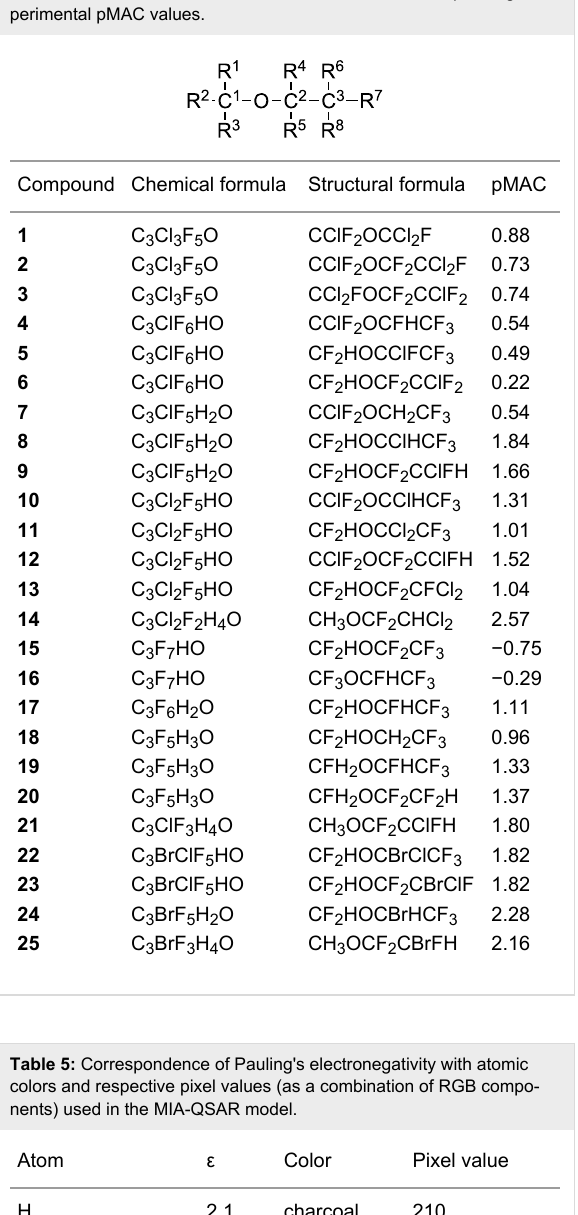
Table 4: Data set of anesthetic haloethers and the corresponding ex- perimental pMAC values.